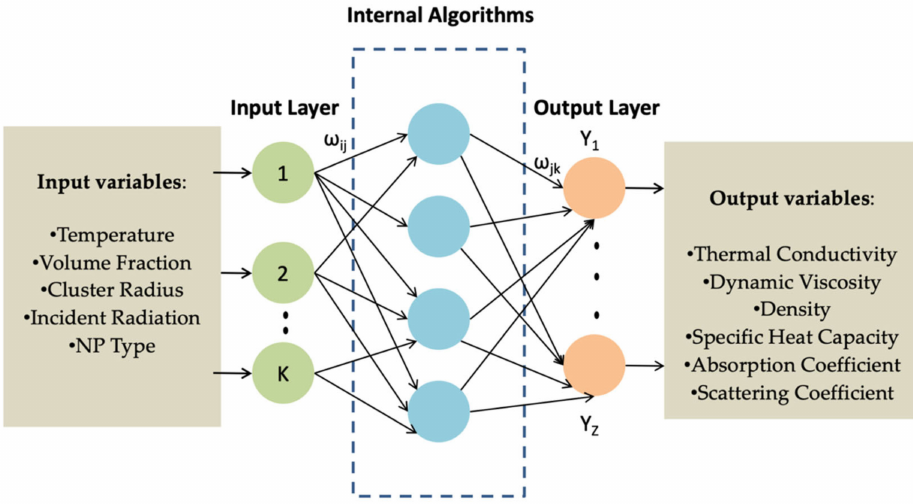
Figure 7. Schematic structure of the Artificial Neural Network (ANN) machine learning model topology (Adapted and abridged from